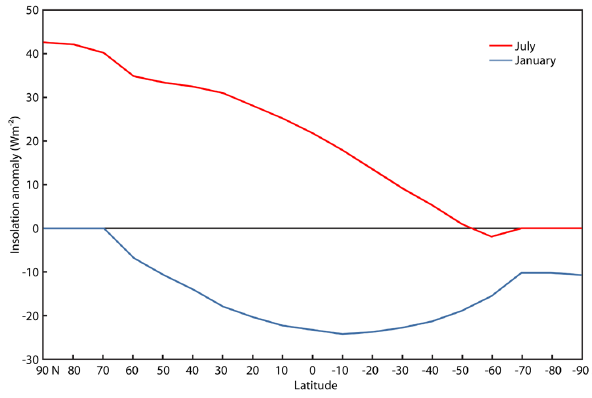
Fig. 4. Insolation anomalies (Wm − 2 ) for 130kaBP as a function of latitude compared to pre-industrial values (Berger, 1978). The Northern Hemisphere winter (January) period is given in blue and the summer (July) period in red. The insolation is calculated using a calendar in which the vernal equinox is fixed at 21 March at noon and the months or seasons are defined based on the present-day cal-